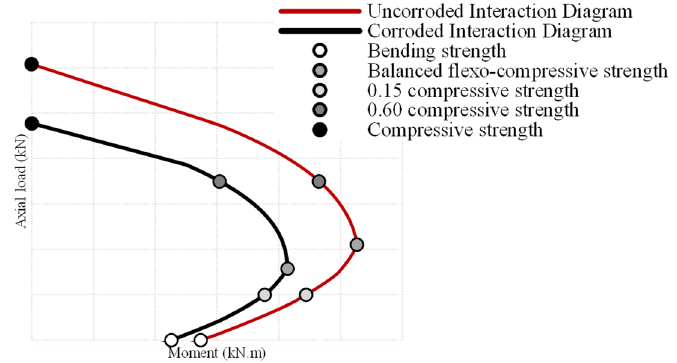
Figure 13. Analyzed strengths capacities.